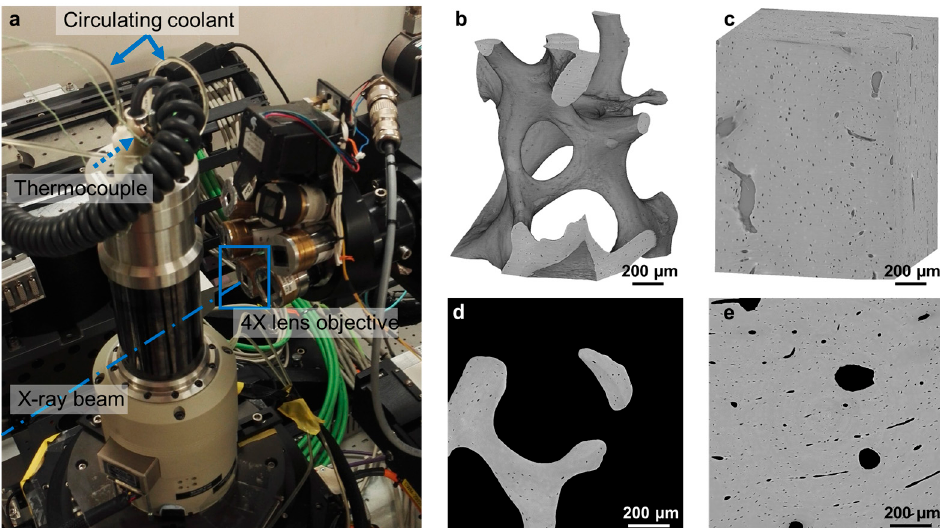
Figure 1. ( a ) Experimental setup at I13-2 beamline. The direction of the beam is indicated by the dashed-dotted line. Specimens were scanned within a loading device using a 4× lens objective.